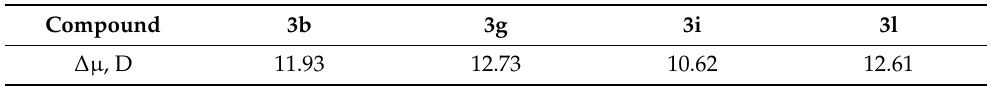
Table 2. Differences between the calculated dipole moments ∆ µ of optimized equilibrium model structures 3b , g , i , l in the ground, (S 0 ) excited, and (S 1 ) multiplicity states. Compound 3b